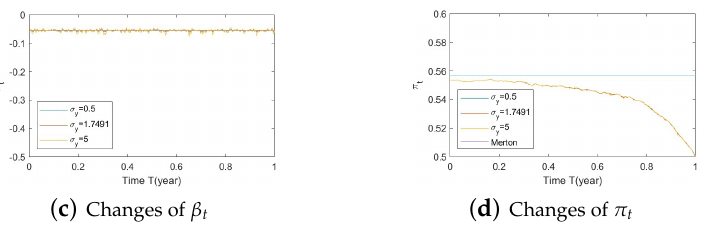
Figure A18. Illustrate the impact on ( a ) stock prices, ( b ) driver of elasticity, ( c ) elasticity of volatility, and ( d ) optimal stock allocations when varying σ y ( e . g ., σ y = 0.5,1.7491,5 ) .